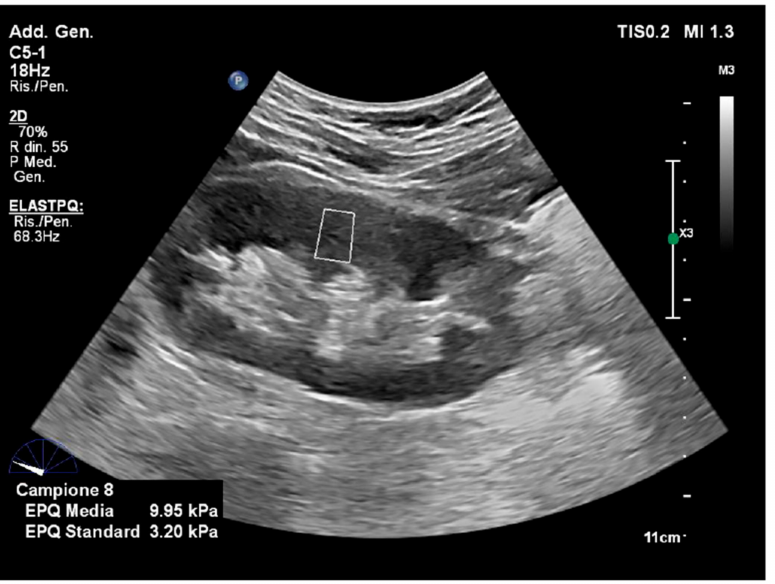
Figure 11. Point shear wave elastography. The image is obtained with point shear-wave elastography (ElastQ, Philips), using a convex probe in a healthy volunteer. A small ROI (white square) is placed in the middle third of the renal parenchyma. The mean stiffness value was 9.95